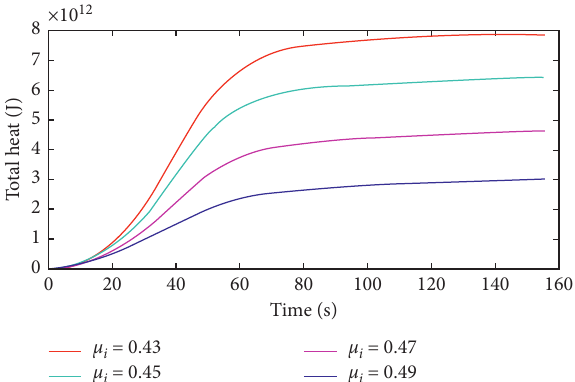
Figure 19: Total heat change curve under different internal friction